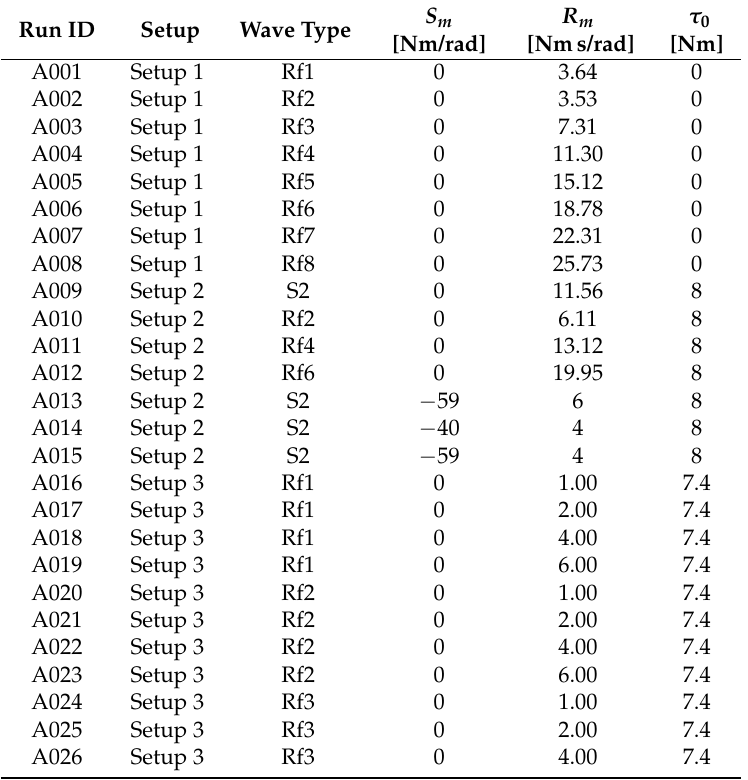
Table A1. List of Experimental Test Runs Carried out during the Experimental Campaign. Run ID